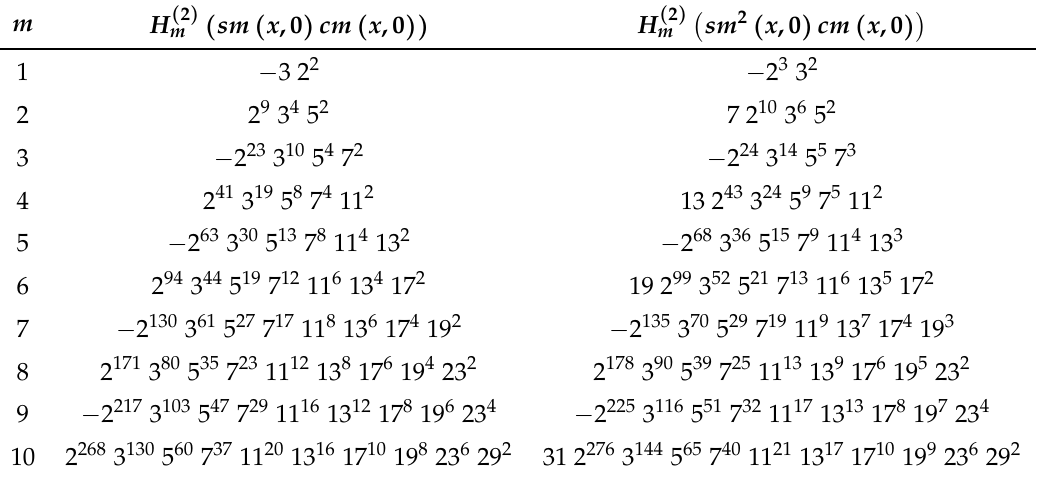
Hankel determinants H sm 2 ( x ,0 ) cm ( x ,0 ) for m from